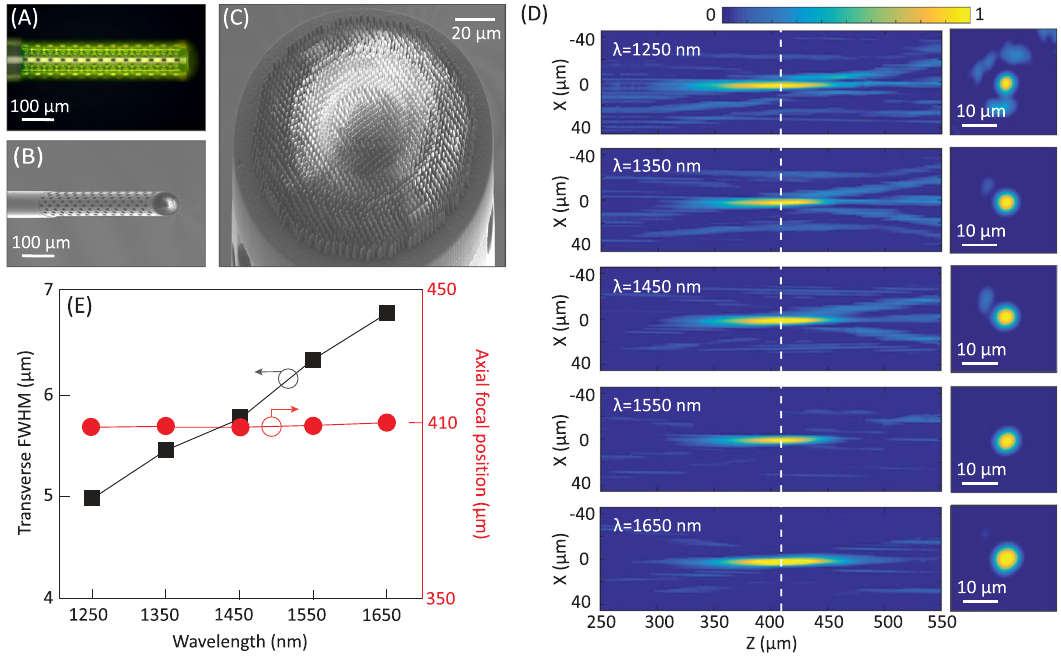
Fig. 4 Focusing performance of a 3D-nanoprinted achromatic meta fi ber. A – C Optical ( A ) and SEM ( B , C ) images of the achromatic meta fi ber. D Experimentally characterized point-spread functions of the achromatic meta fi ber in both longitudinal (left) and transverse (right) planes at fi ve different wavelengths of 1250, 1350, 1450, 1550, and 1650 nm, respectively. E Experimentally characterized transverse FWHM and the axial focal positions of the achromatic meta fi ber at different